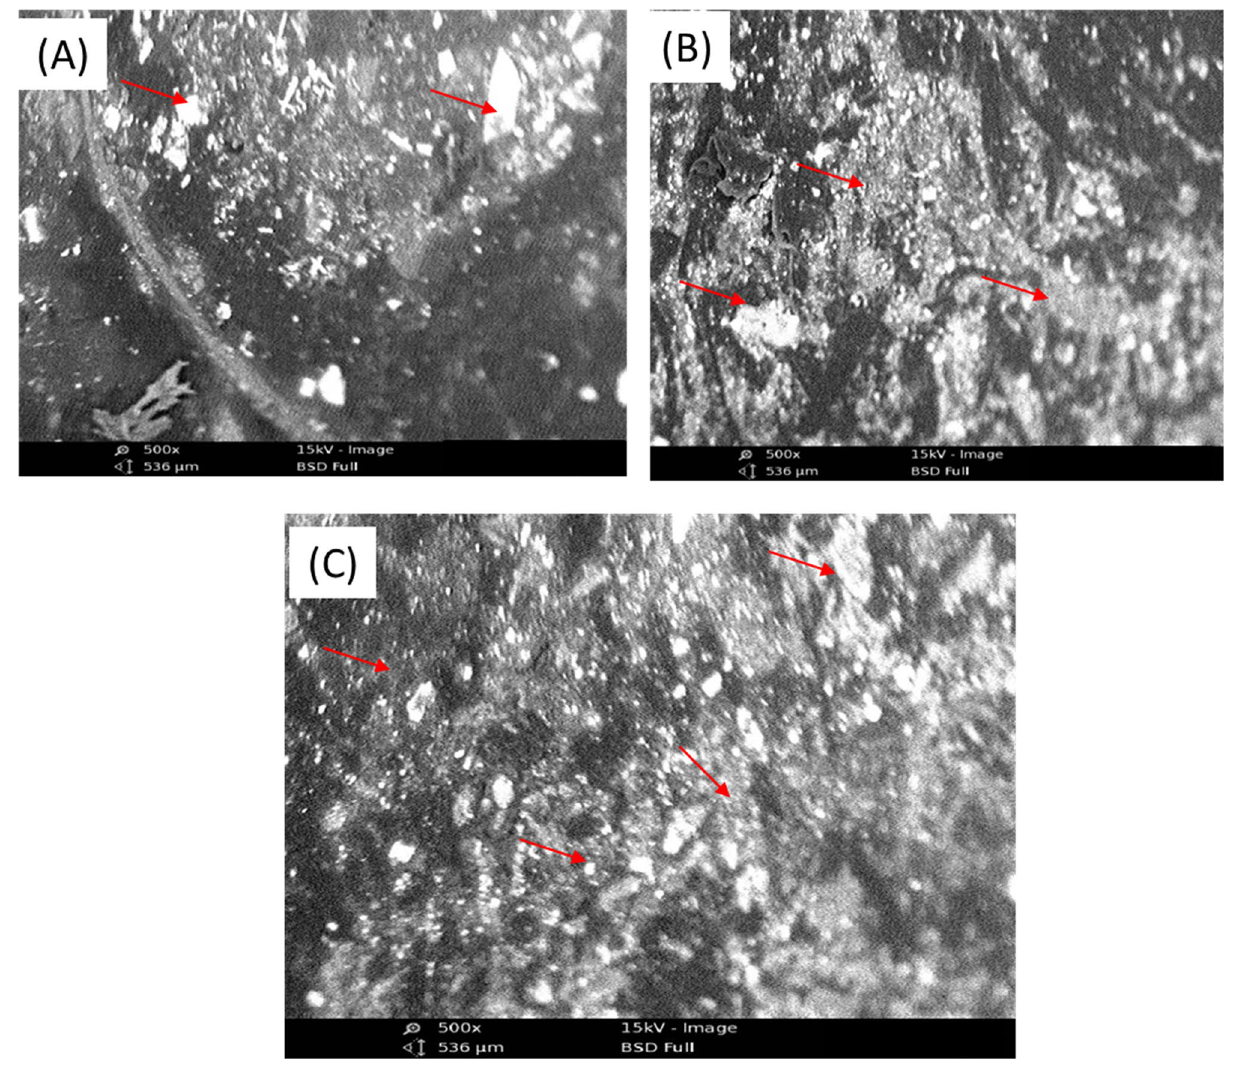
Figure 4. SEM Micrograph of ( A ) Composite with no particulate fibre, ( B ) composite with untreated tiger nut particulate fibre, ( C ) composite with treated tiger nut particulate